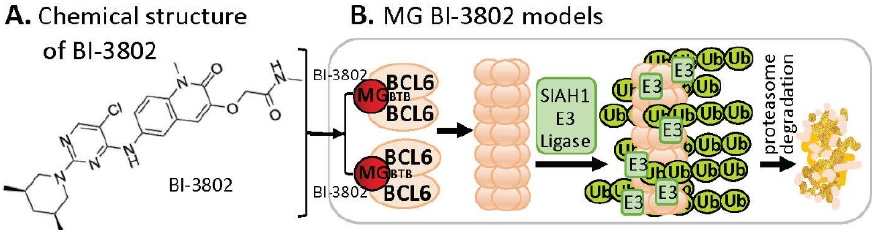
Figure 6. ( A ) The chemical structure of BI-3802 as a special MG compound; ( B ) the diagram model for BI-3802-induced BCL6 polymerization, ubiquitination, and degradation. BI-3802 through the BTB domain of BCL6 makes BCL6 dimerization and then induces the dimerized BCL6 formation of helical filament. The polymerized BCL6 enhances the E3 ligase SIAHI interaction and ubiquitination of the polymerized BCL6 protein for degradation through the ubiquitination proteasome